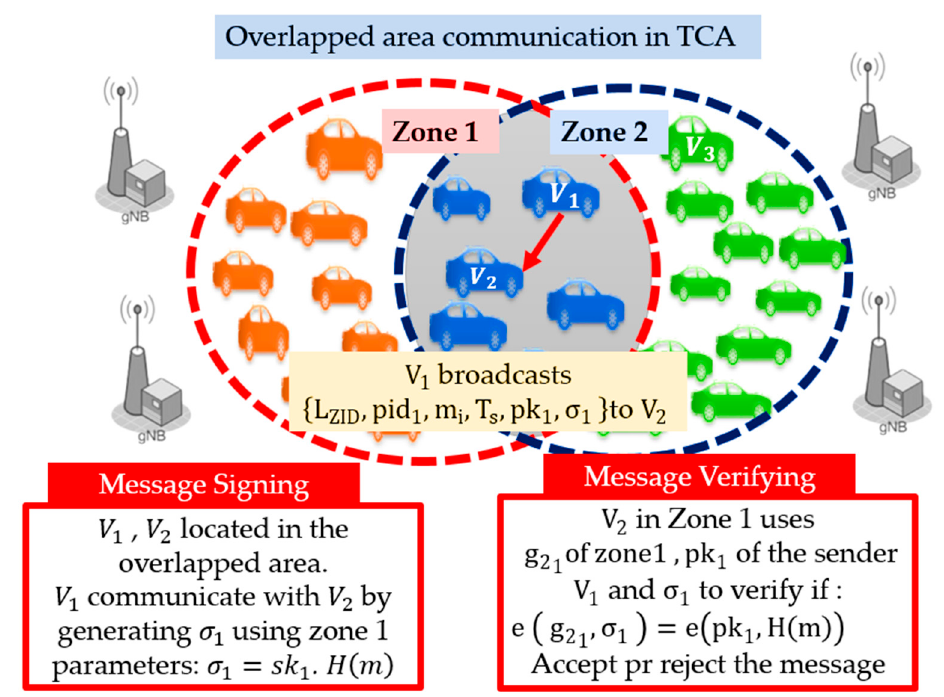
Figure 6. Overlapped area communication in TCA method. Multi-Zone Case: The multi-zone communication of the TCA method is shown in Figure 7. Here, transmitter 𝑉 (cid:2869) joins zone 1 and zone 2, and thus 𝑉 (cid:2869) simultaneously trans- mits to 𝑉 (cid:2870) in zone 1 and 𝑉 (cid:2871) in zone 2. In the TCA method, 𝑉 (cid:2869) signs the message using zone 1 parameters, while the receivers 𝑉 (cid:2869) in zone 1 and 𝑉 (cid:2870) in zone 2 verify using the same parameters as the transmitter.